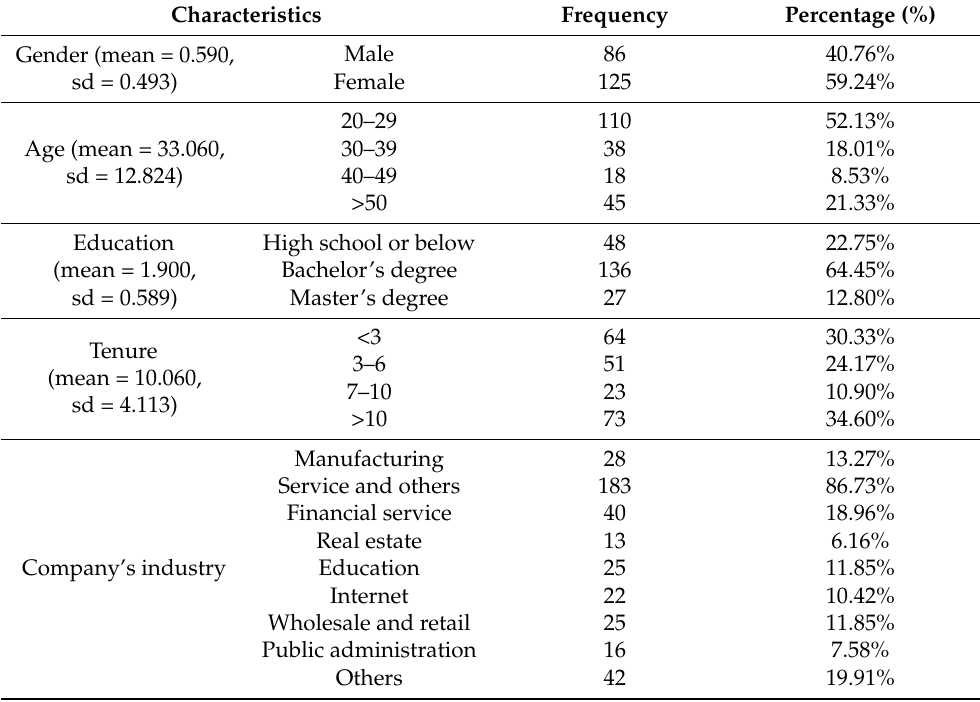
Table 1. Characteristics of the